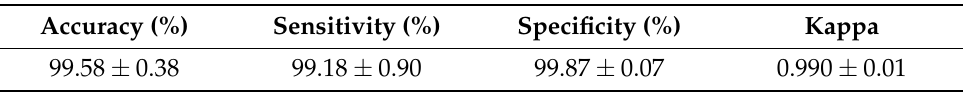
Figure 5. Graphs of accuracy vs. epochs of multi-channel multi-scale deep CNN obtained using training and validation VCG instances for MI detection. Table 3. Classification results of two class multi-channel multi-scale deep CNN obtained for the detection of MI using hold-out validation.